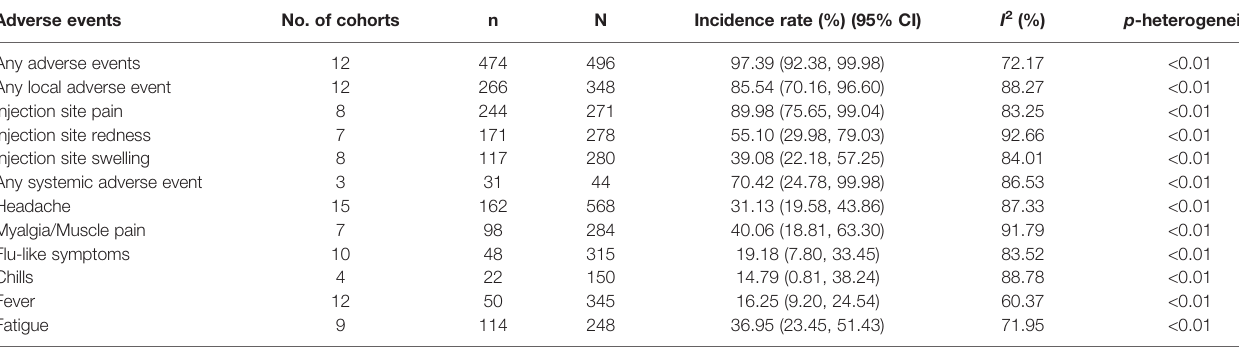
TABLE 4 | Safety of therapeutic vaccines for precancerous cervical